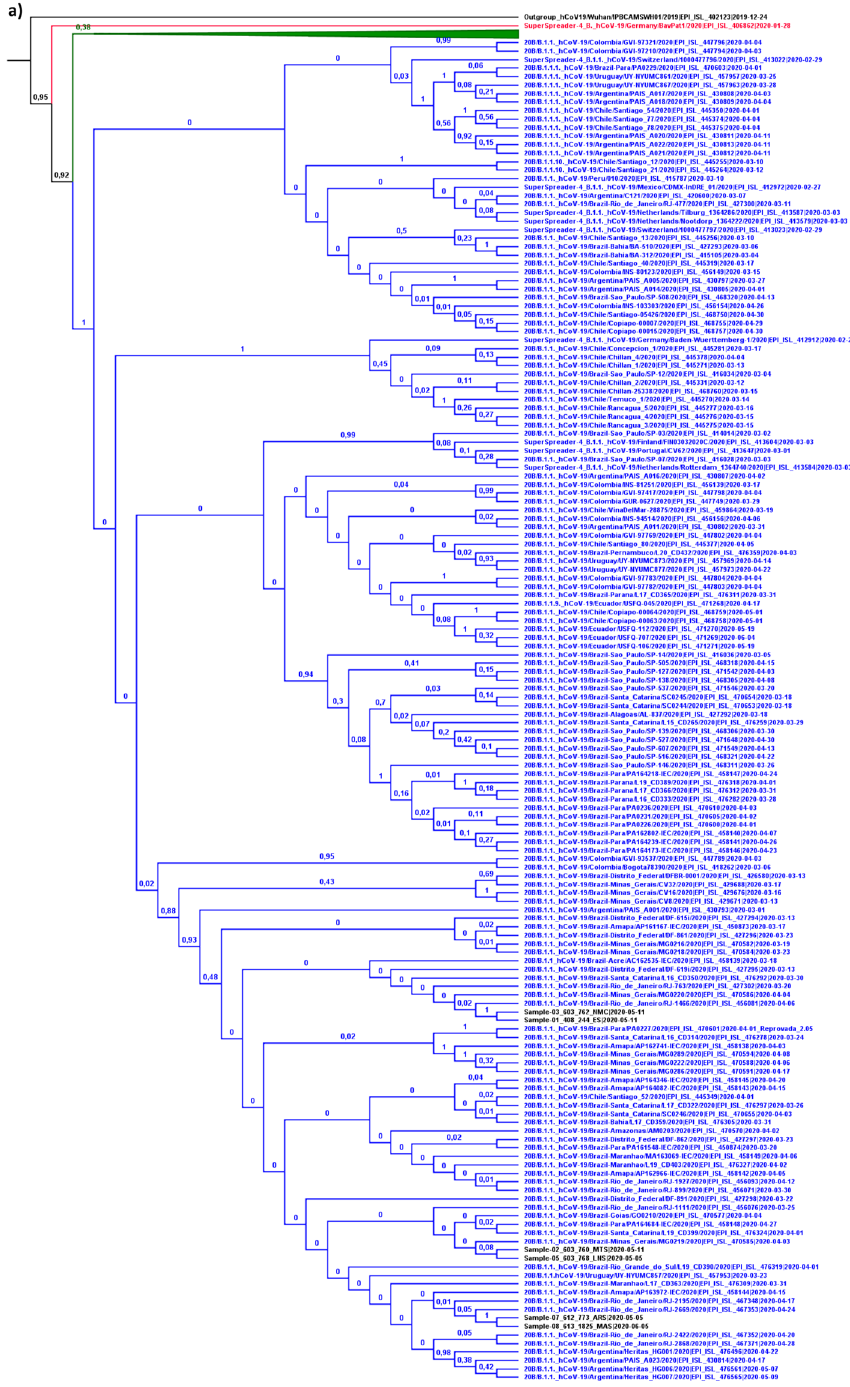
Figure 3. Bayesian phylogenetic tree for detailing the evolutionary path. In the generated MCC tree, the phylogenetic relationship was estimated based on 307 SARS-CoV-2 sequences included in dataset B. ( a ) The taxa and clades colored in blue correspond to strains belonging to variations of pangolin lineage B.1.1., including: B.1.1., B.1.1.1., B.1.1.10. and B.1.1.9. ( b ) The green colored taxa and clades correspond to strains belonging to other variations of pangolin lineage B.1., Including: B.1., B.1.3., B.1.5., B.1.5.4., B. 1.67. and B.1.8. The study samples are colored black, along with the sequence used for rooting the inferred tree. In each node, the subsequent probability rate for supporting the branches in decimal data is shown. The tMRCA among all variations of SARS-CoV-2 was dated to November 20, 2019 (95% HPD between October 17 and December present